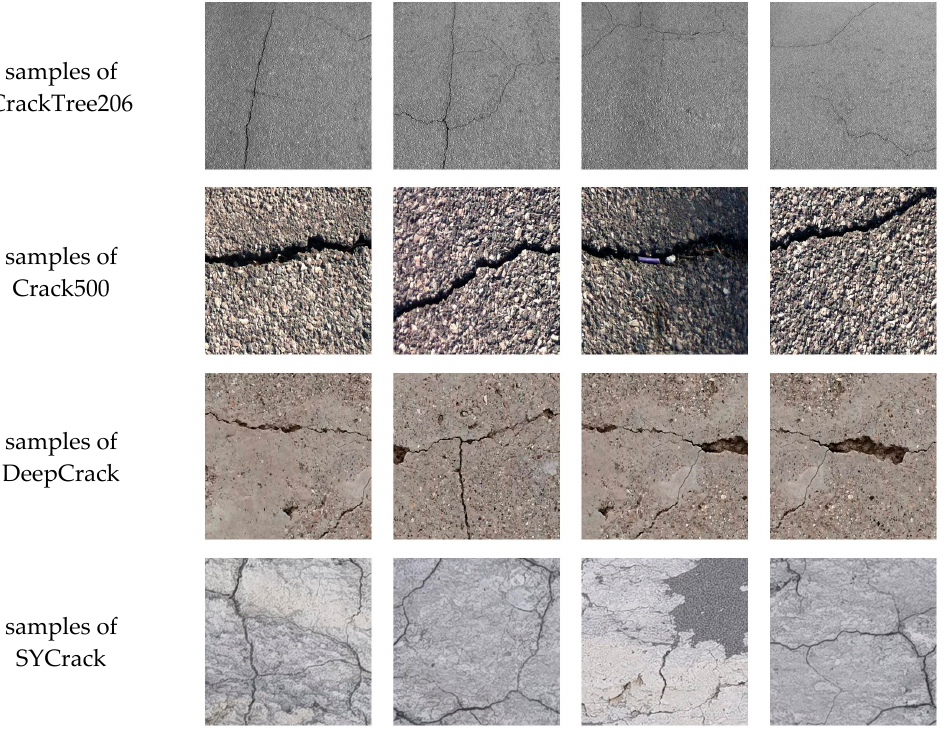
Figure 3. Samples of cracks in the training dataset.